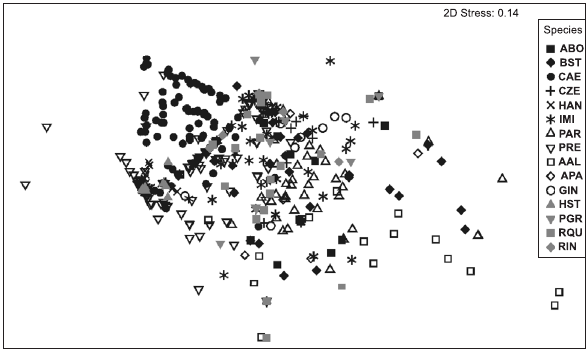
Figure 2. Two-dimensional plot of the fifteen species analyzed show- ing the ordination resulting from the NMDS. ABO = Astyanax bockmanni ; AAL = Astyanax altiparanae ; APA = Astyanax aff. paranae ; BST = Bryconamericus stramineus ; CAE = Corydoras aeneus ; CZE = Characidium aff. zebra ; GIN = Gymnotus inaequilabiatus ; HAN = Hypostomus ancistroides ; HST = Hypostomus cf. strigaticeps ; IMI = Imparfinis mirini ; PAR = Piabina argentea ; PGR = Pimelodella gracilis ; PRE = Poecilia reticulata ; RIN = Rineloricaria sp.; RQU = Rhamdia quelen .